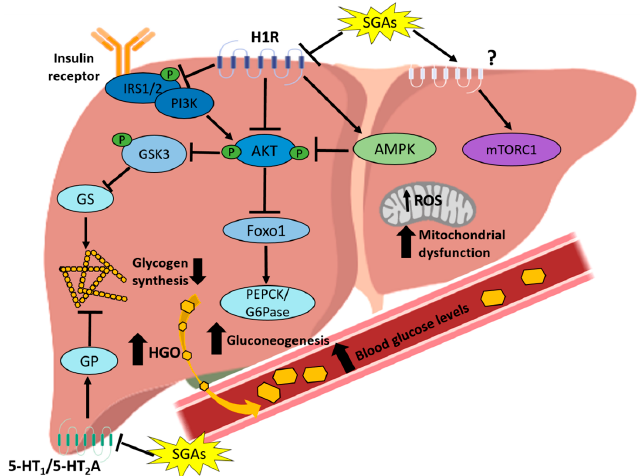
Figure 2. SGA-induced impairment in hepatic insulin signaling and glucose metabolism. SGAs impact the insulin signaling pathway at two levels: inhibition of IRS-1 / 2 phosphorylation and inhibition of AKT and GSK3 phosphorylation, with H1R antagonism being the proposed SGA target in insulin signaling impairment. Antagonism of 5-HT 1 and 5-HT 2 A and inhibition of glycogen phosphorylase (GP) would decrease glycogen synthesis, an effect also enhanced by inhibition of glycogen synthase (GS). Both inhibition of glycogen synthesis and stimulation of gluconeogenesis by SGAs increase the hepatic glucose output (HGO), leading to an increase in blood glucose levels. SGAs have been also shown to activate both hepatic catabolic (AMPK) and anabolic (mTORC1) pathways and also induce ROS production and mitochondrial dysfunction.